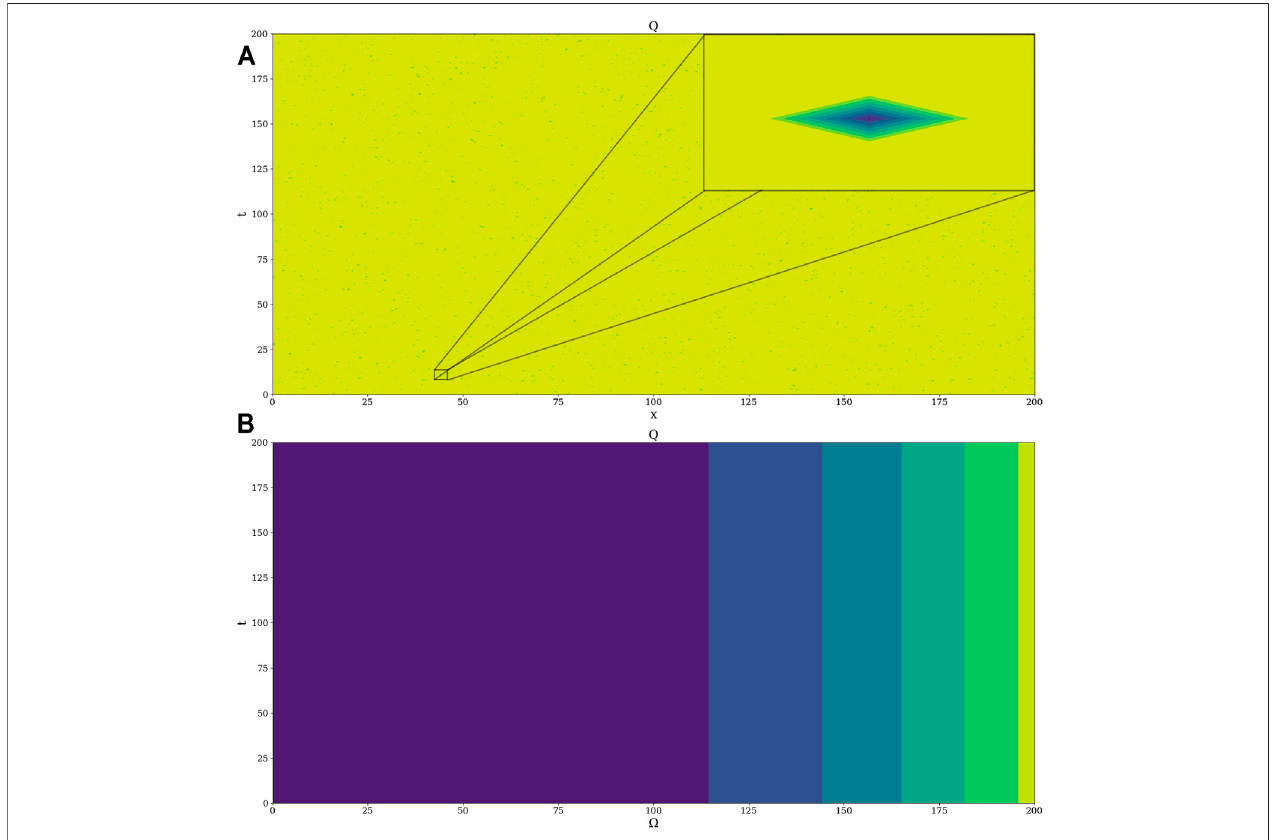
FIGURE 7 | Example 2D plot of Q ( x , t ) ; (A) zoom-in of spontaneous symmetry break peak (top-right); Ω (cid:2) 2 . 1, Φ (cid:2) 2 . 35, (B) x (cid:2) 5, Φ (cid:2) 2 . 35.